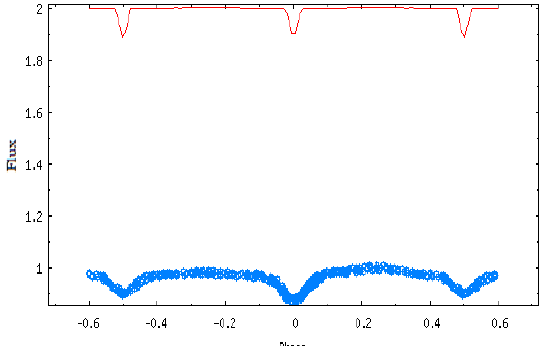
Fig.4: Synthetic and plotted light curves of eclipsing binary BH Vir.